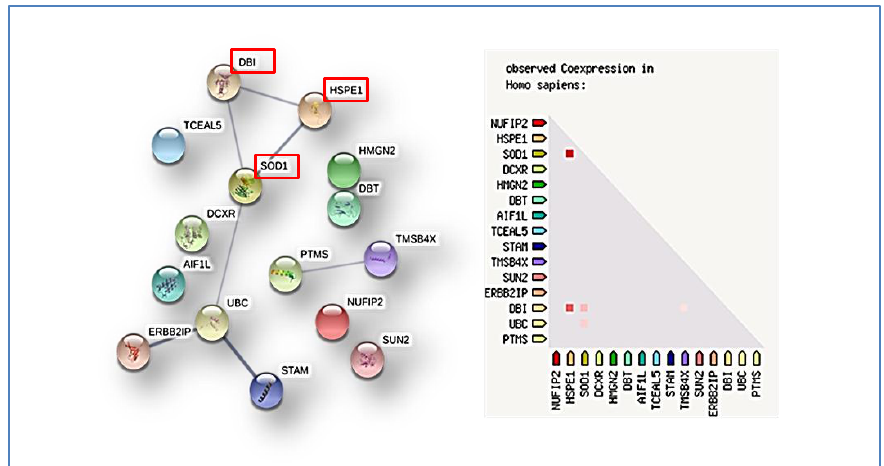
Figure 11. Protein–protein association network (medium confidence 0.400) (left panel) and co-expression (right panel) of the proteins elements distinguishing ST- from PF-EPs, resulting from integrated top-down/shotgun proteomic analysis. Cancer related proteins are marked in red.